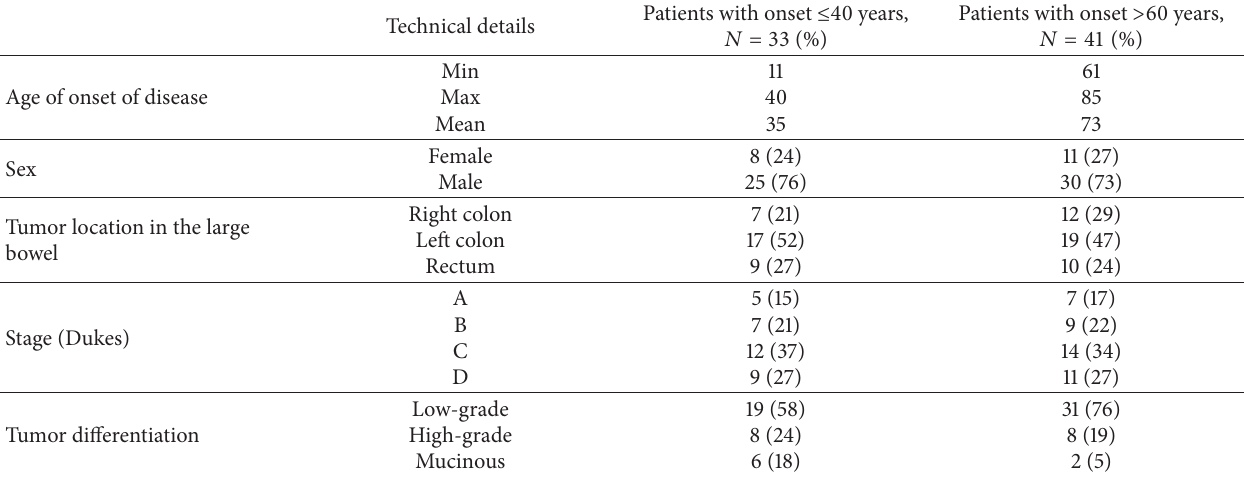
Table 1: Clinicopathological features of 33 colorectal adenocarcinomas (and patients) developed ≤ 40 years (1984–2008) compared to patients with cancer onset > 60